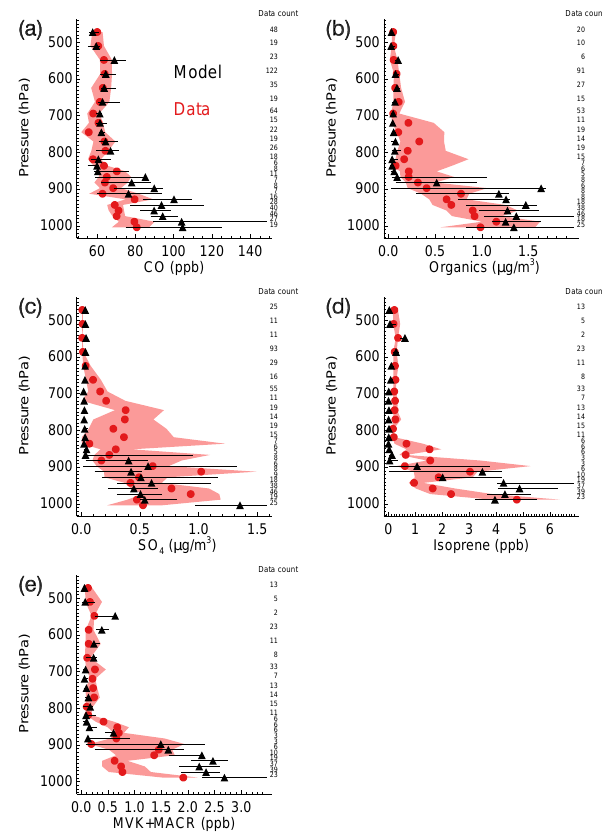
Fig. 2. Median statistics for BAe 146 UK research aircraft (red circle) and GEOS-Chem model (black triangle) concentration pro- files for (a) CO [ppb], (b) organic aerosol [µgm − 3 ], (c) SO 2 − [µgm − 3 ], (d) Isoprene [ppb], and (e) the sum of methyl vinyl ke- tone (MVK) and methacrolein (MACR) during July 2008 as part of the ACES/OP3 measurement campaign. The nested grid model is sampled at the same time and location of each aircraft measure- ment along the flight track. The black horizontal lines and the pink shaded envelope denote the 25th and 75th percentiles, respectively. The number of data points used at each altitude is shown in the R.H.S. axis of each